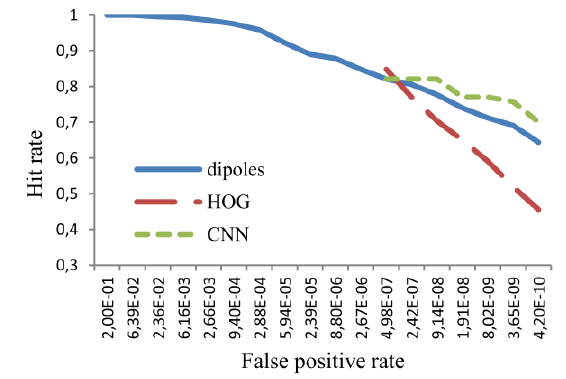
Figure 6 : Comparison of different features and classifier used on the last stages of cascade for the red triangles